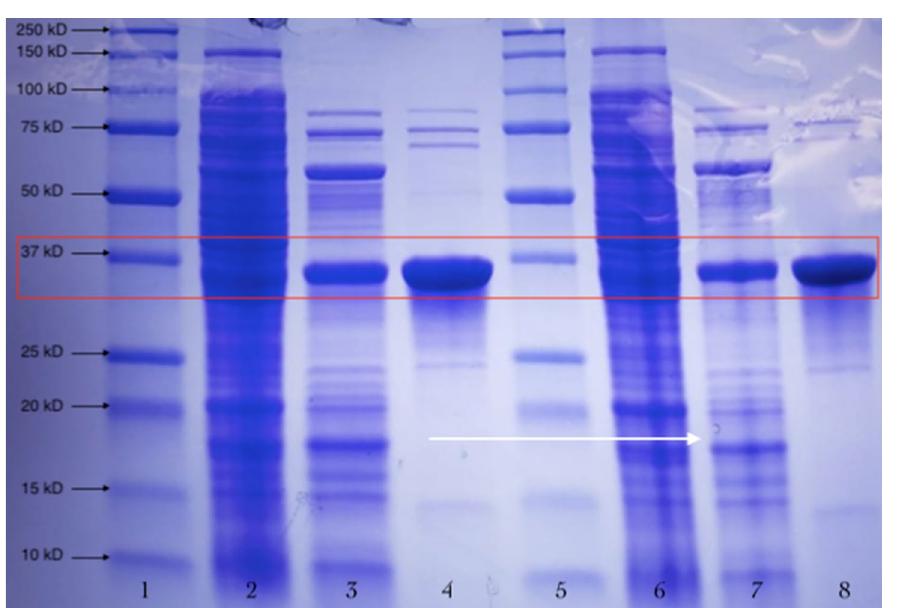
Figure 2. Chromatographically purified GH5-tCel5A1 cellulase, the heat-treated crude GH5-tCel5A1 cellulase extract and crude GH5-tCel5A1 cellulase extract were further analyzed by SDS-PAGE with gel stained with Coomassie blue gel and the GH5-tCel5A1 target protein at the estimated molecular weight as about 37 kDa shown in the red square. Lanes 1 and 5 , protein molecular ladders; Lanes 2 and 6 , crude extract of the GH5- tCel5A1; Lanes 3 and 7 , the heat-treated GH5-tCel5A1; and Lanes 4 and 8 , the purified GH5-tCel5A1